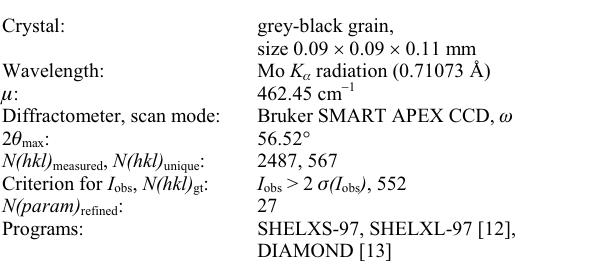
Table 1. Data collection and